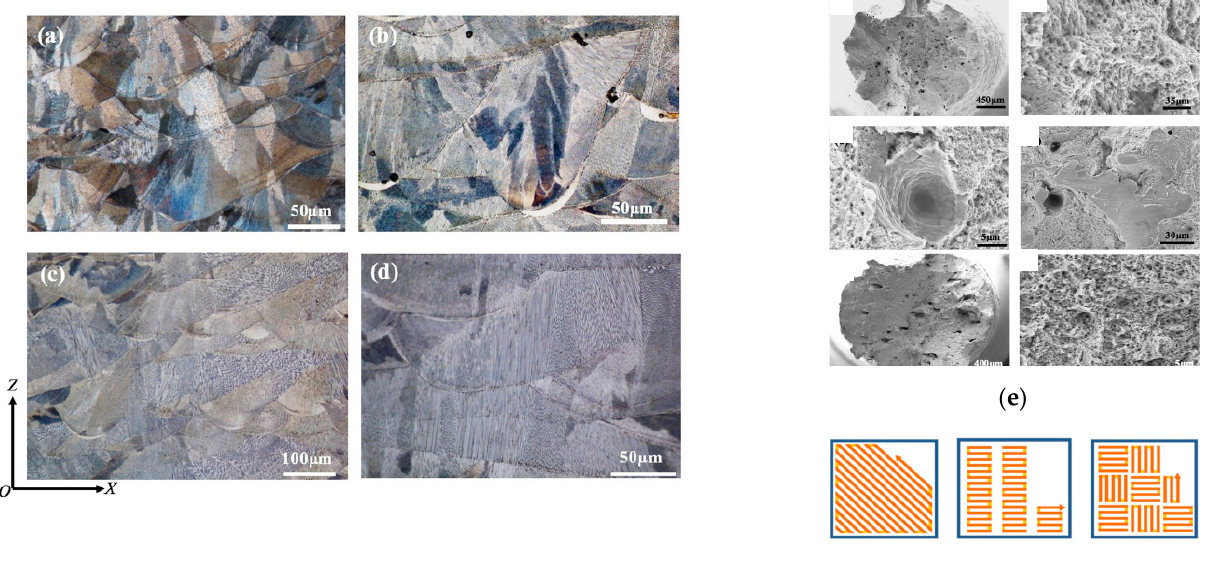
Figure 21. ( a – d ) High magnification of micro-graphs showing micro-structure of 316 L samples fabricated at 200 W using different scanning strategies, ( e ) Additional SEM micro-graphs, ( f ) Schematic of different laser scanning strategies, i.e., Meander, Stripes and chessboard [61] (open access article distributed under the terms and conditions of the Creative Commons Attribution (CC BY) license).